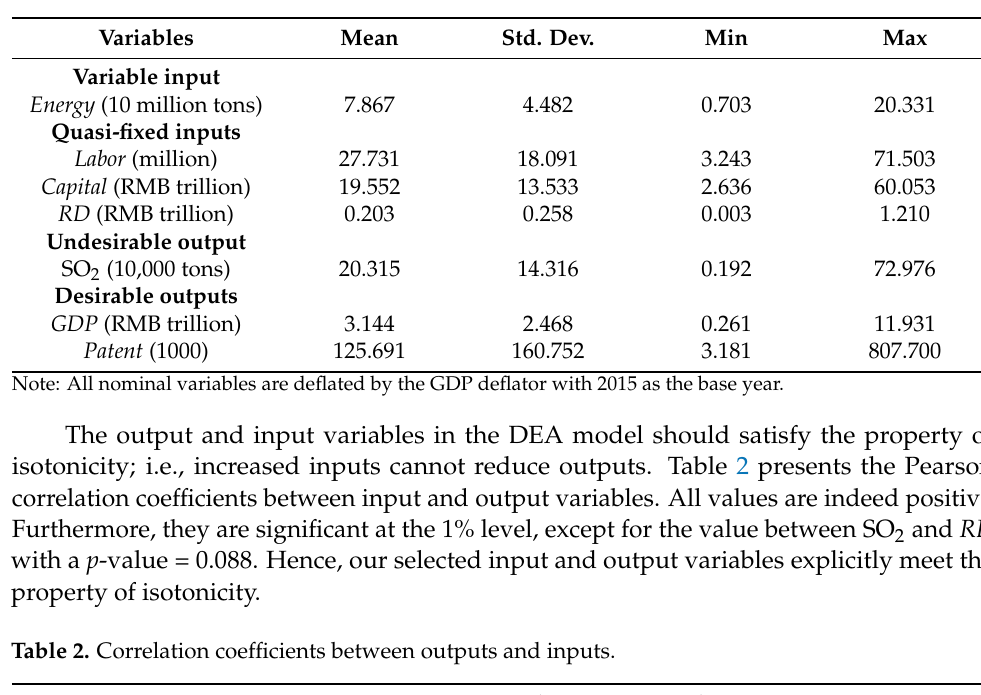
Table 1. Descriptive statistics of inputs and outputs.